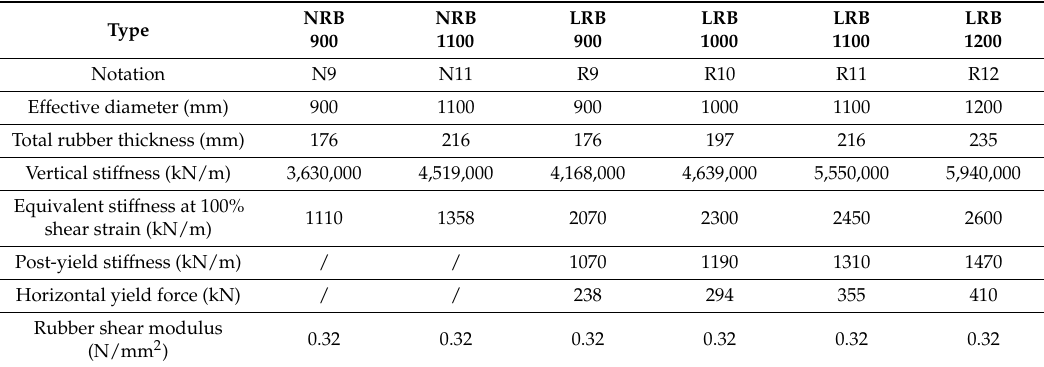
Table 1. Characteristic parameters of the